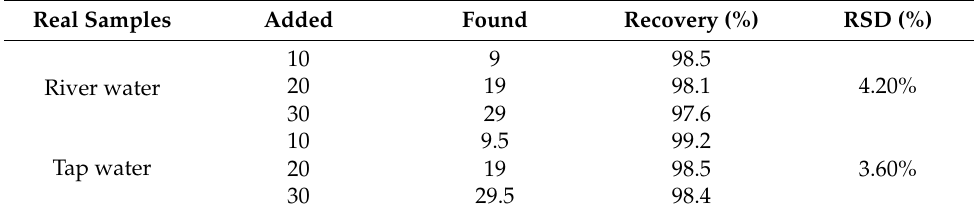
Table 2. Outcomes for the detection of CIP in various real